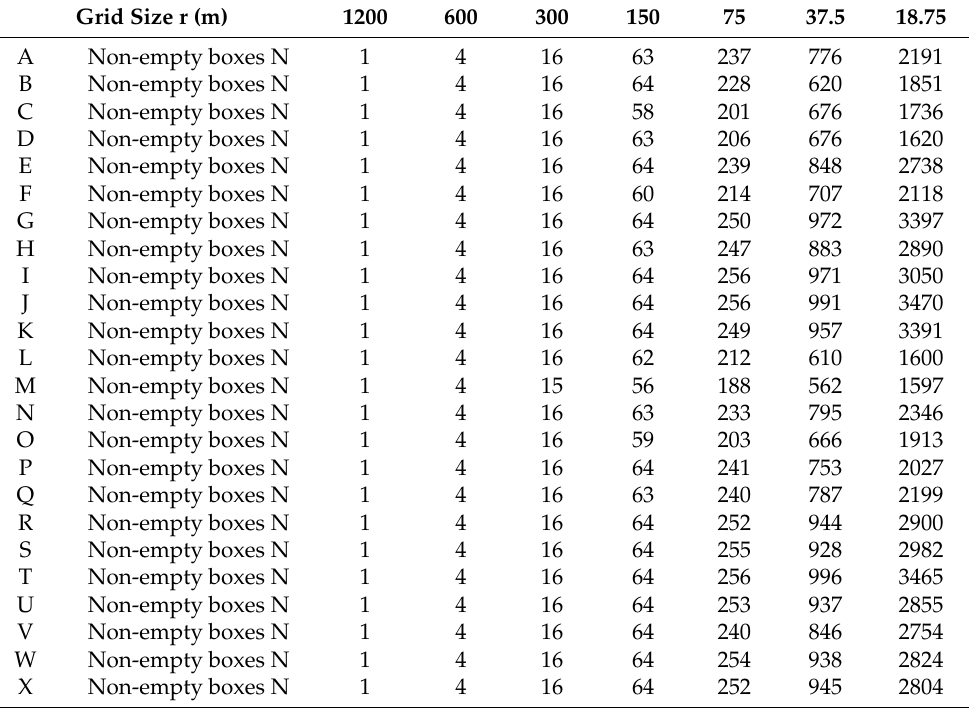
Table 3. Summary of results for various sizes of 2D boxes for the sub-research